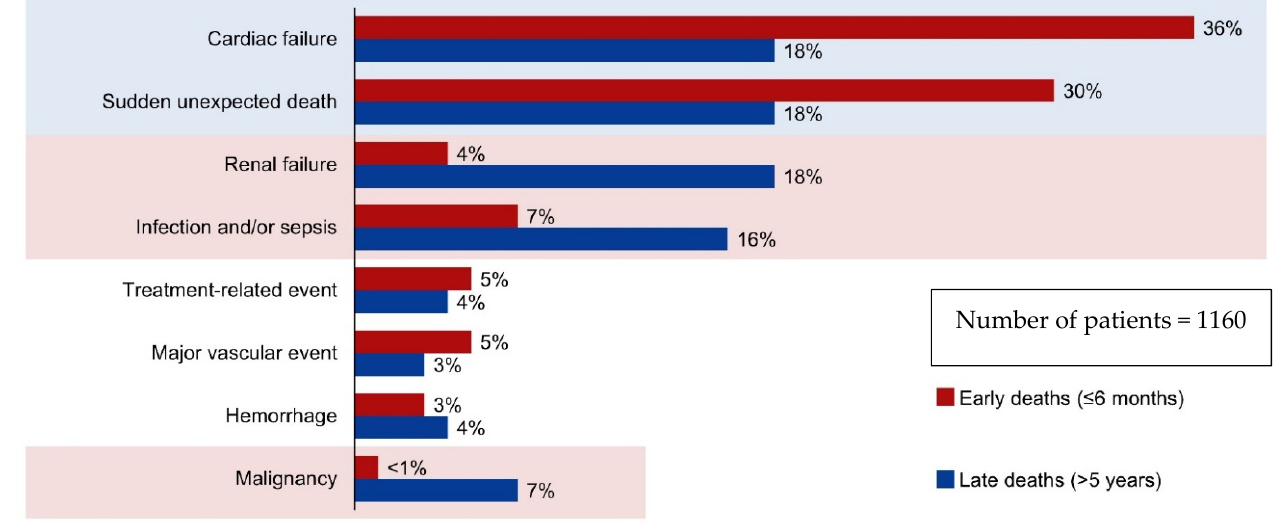
Figure 1. Causes of early and late deaths in a longitudinal natural history study [10] .